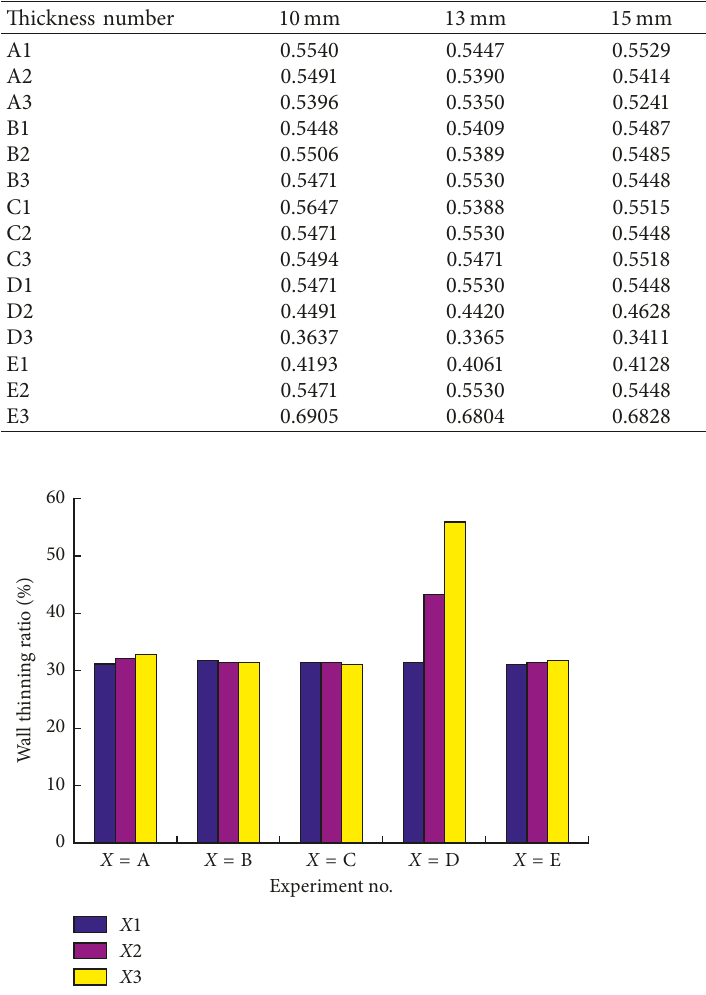
Figure 7: Relationship between thickness thinning ratio and process parameters.